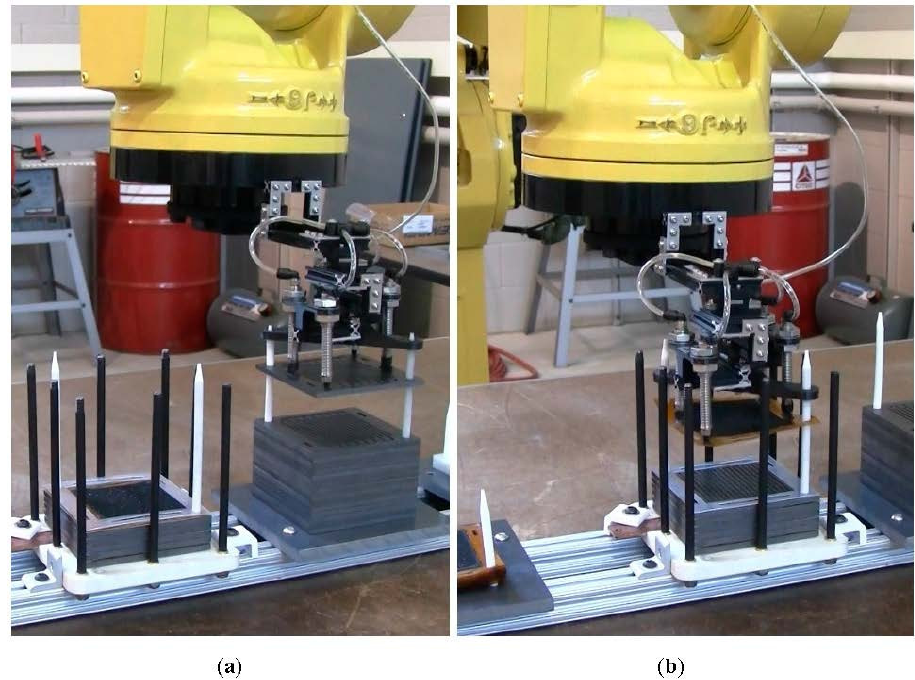
Figure 6. ( a ) Pick up operation of a bipolar plate; ( b ) Release operation of